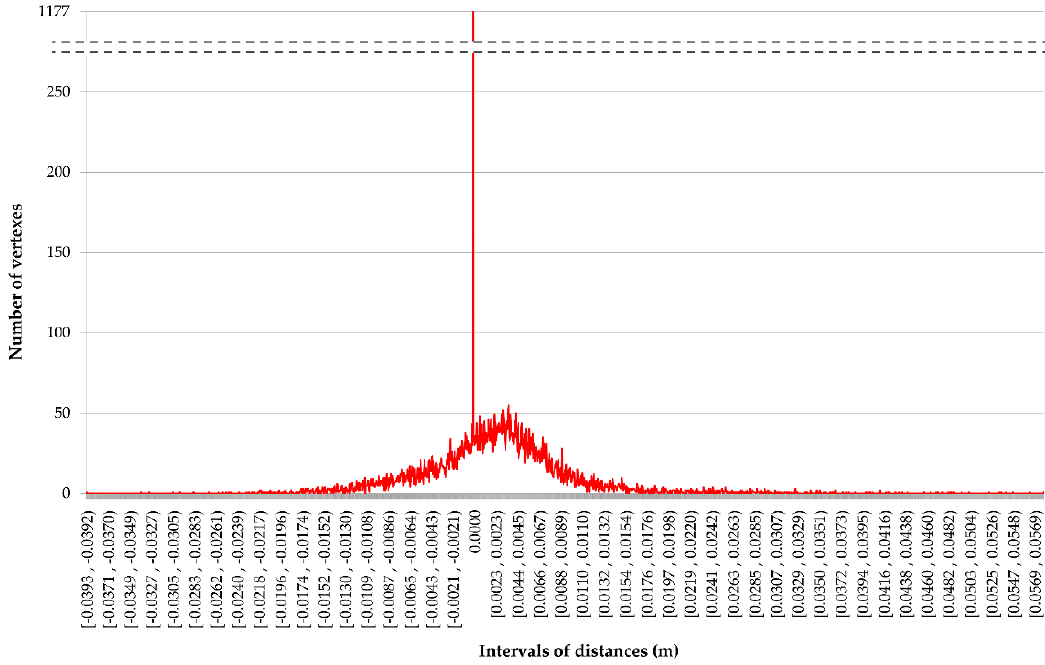
Figure 18. Cloud-to-mesh point deviation in a wall sector.